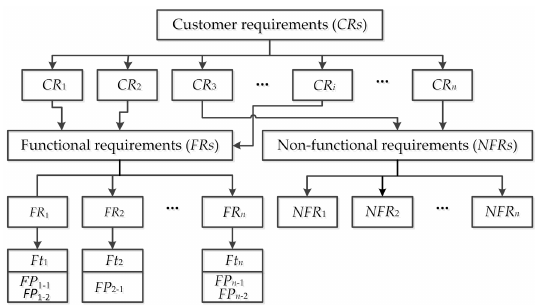
Figure 1. Hierarchical analysis of